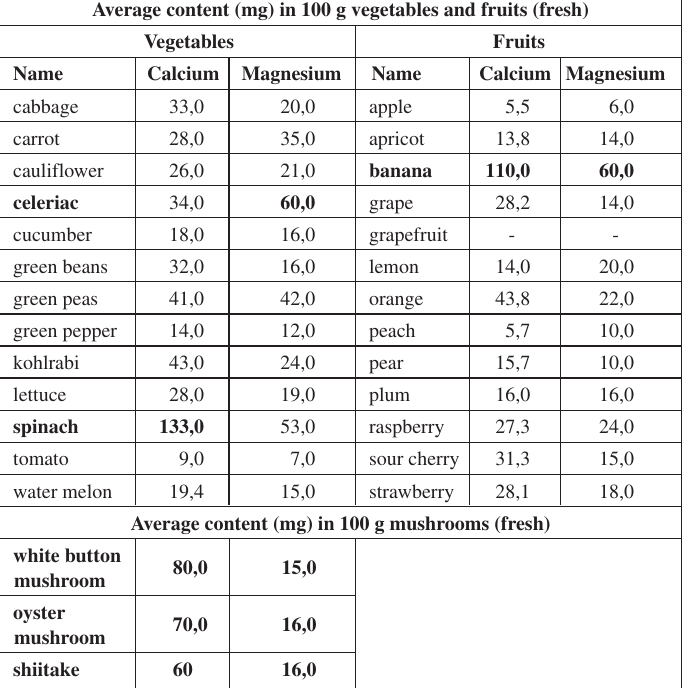
Table 3. Average calcium and magnesium content (µg) in 100 g vegetables, fruits and mushrooms (fresh) Average content (mg) in 100 g vegetables and fruits (fresh)